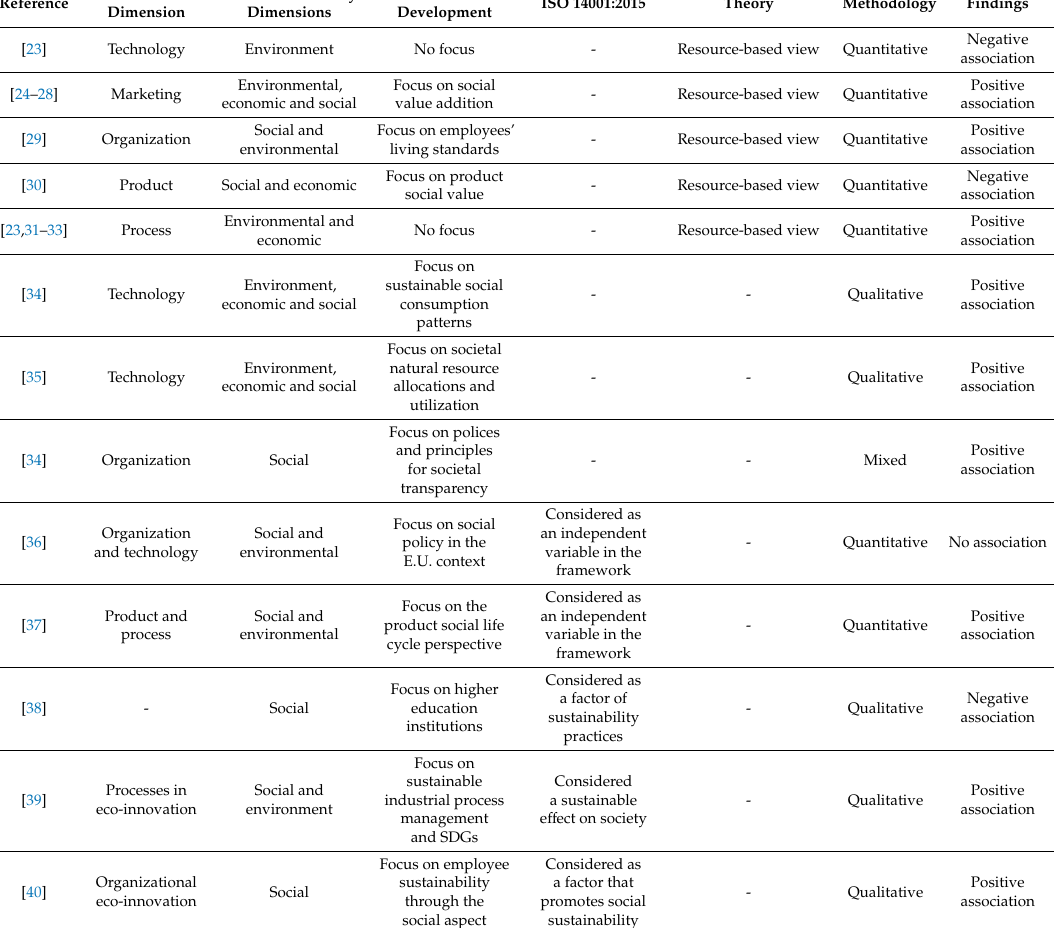
Table 1. Summary of past studies on eco-innovation, firm sustainability, societal developments, and International Organization for Standardization (ISO)